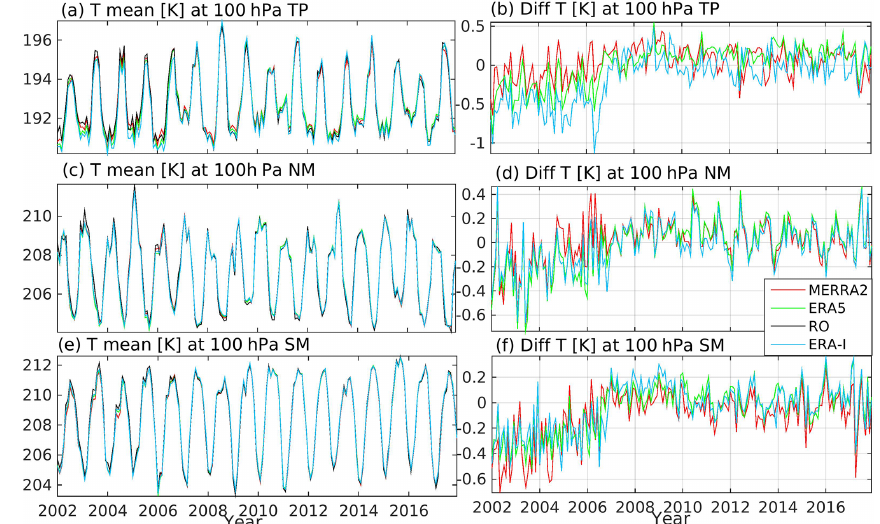
Figure 2. As in Fig. 1 but for 100hPa.